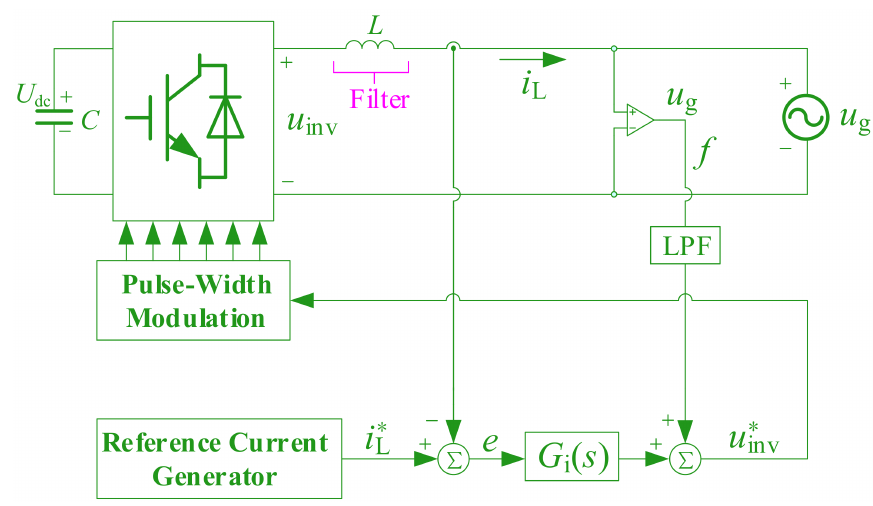
Figure 1. The typical main circuit and control principle of GcC.